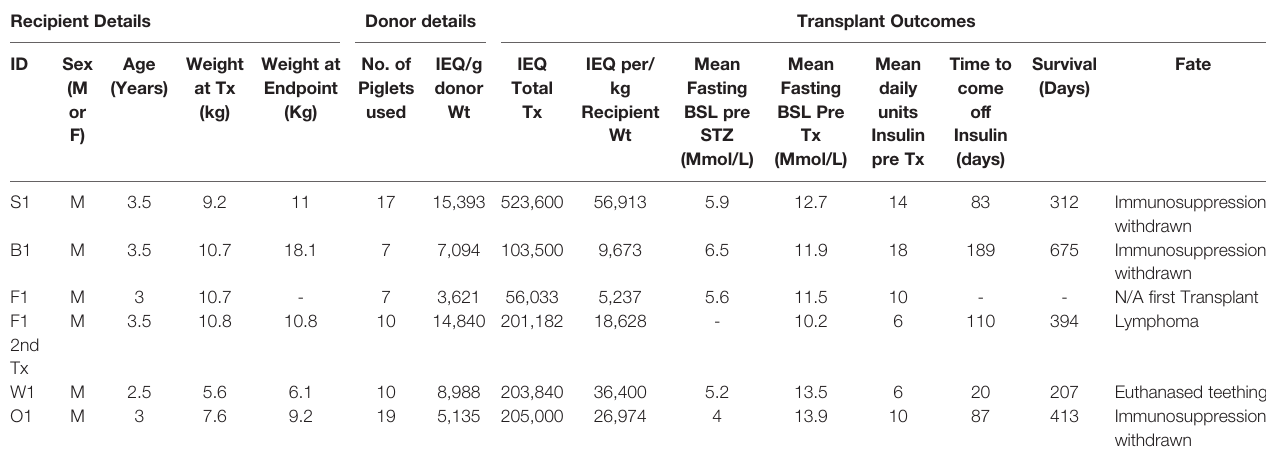
TABLE 1 | Recipient and donor details along with the transplant